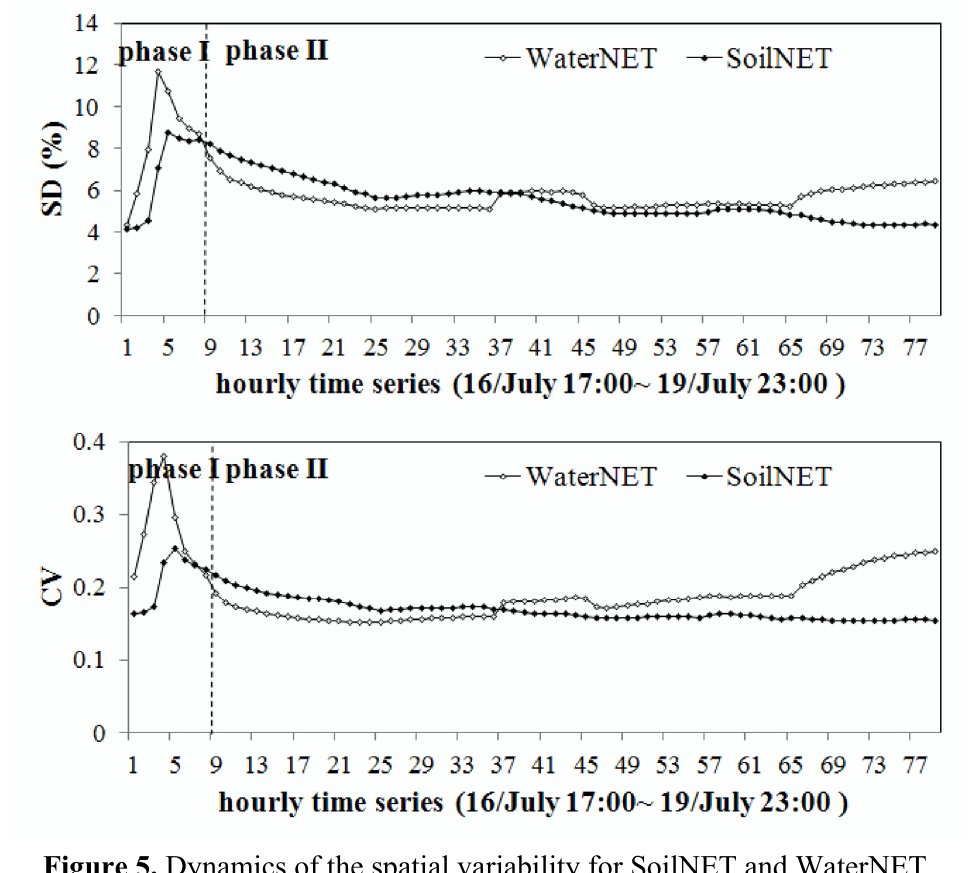
Figure 5. Dynamics of the spatial variability for SoilNET and WaterNET.